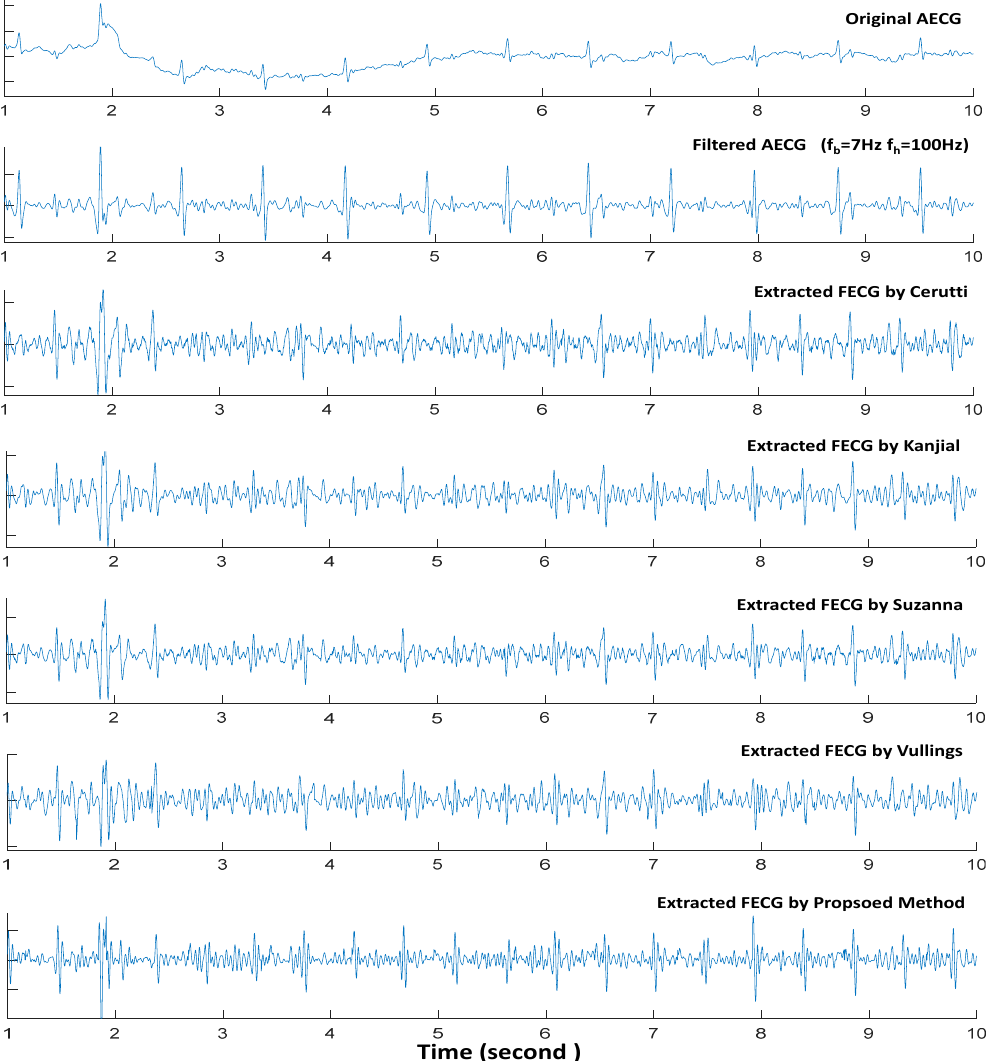
11 of 15 Table 1. FECG QRS detected from statistical assessment of signal r01 (DB1). Methods 3 Table 2. FECG QRS detected from statistical assessment of signal r07 (DB1). Methods